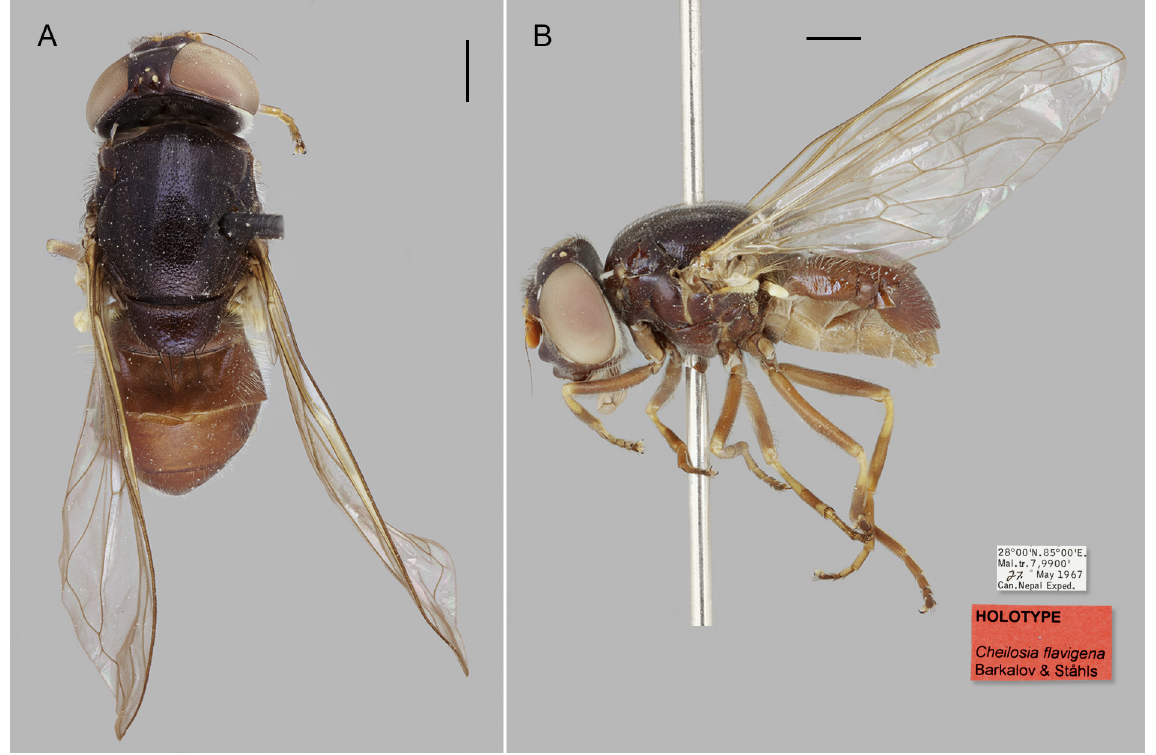
Fig. 23. Cheilosia flavigena sp. nov., holotype, ♀ (CNC); dorsal and lateral views. Photo: Pekka Malinen, FMNH Luomus. Scale bars = 1